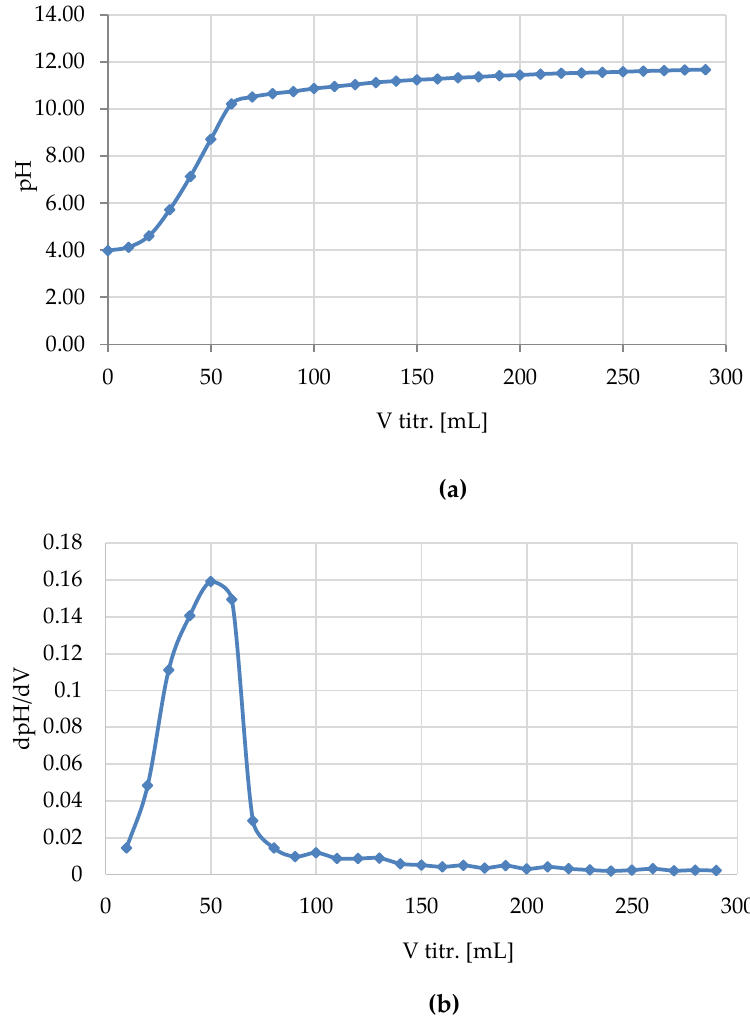
Figure 13. Titration curve of Cell- O 6 -P(O)(OH)-H(48 h) by 0.016 M KOH: ( a ) pH vs. V; ( b ) dpH/dV vs. V. One deflection point of the titration curve of Cell- O 6 -P(O)(H)(OH)-48 sample by KOH confirms the presence of the phosphate(P(III)) function in the molecule of phosphor- ylated cellulose and the absence of the corresponding phosphate(P(V)), excluding its oxi-